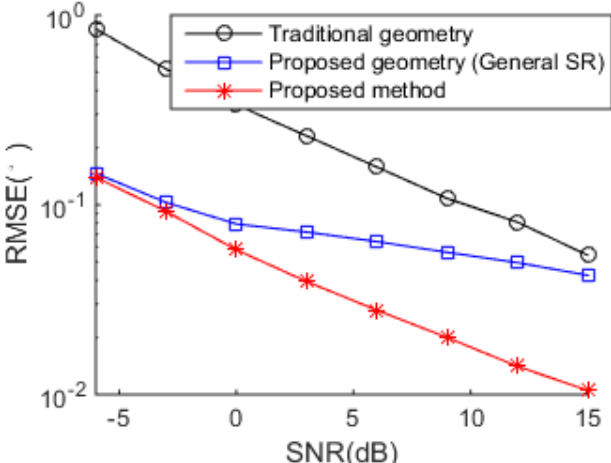
Figure 6. DOA estimation performance improvement contributor verification.